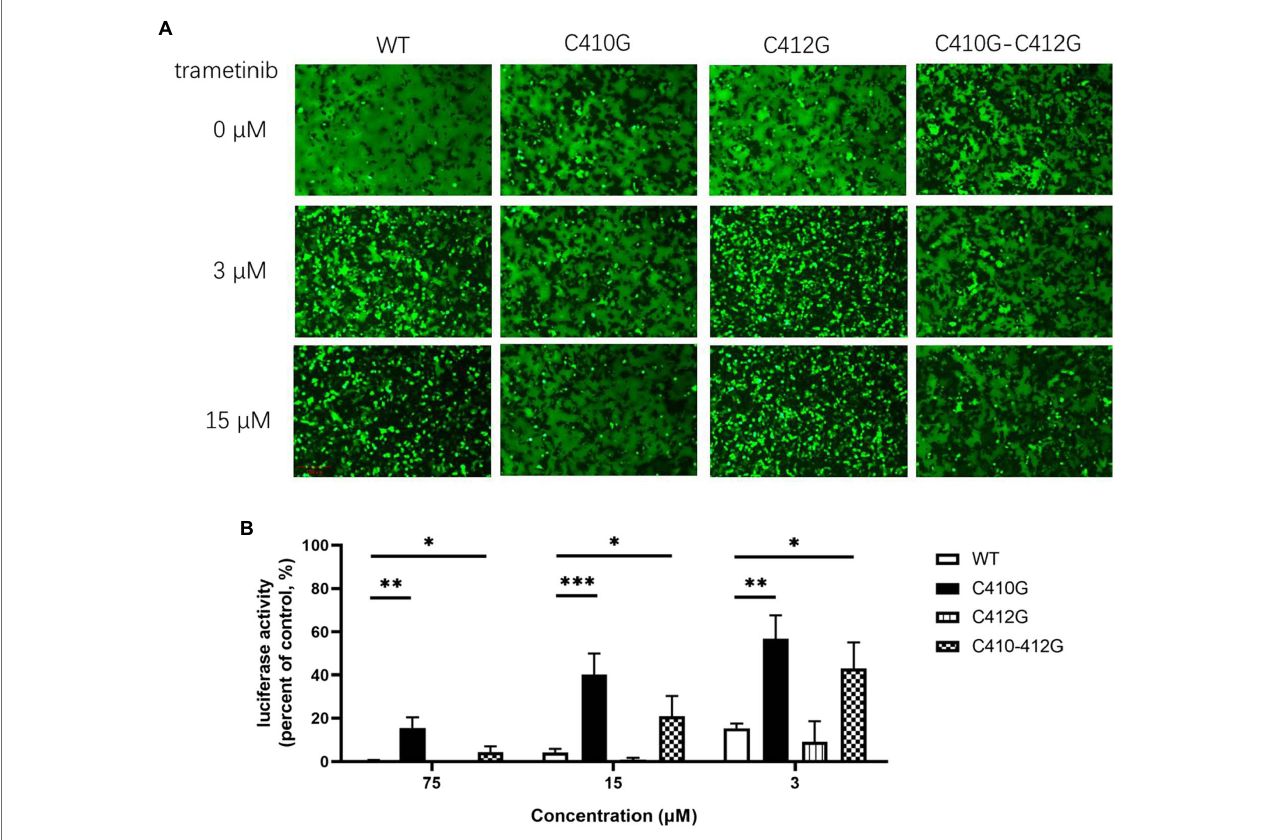
FIGURE 4 | Only C410G, but not C412G, conferred resistance to trametinib. (A) Both C410G and C410G/C412G mutants conferred resistance to the inhibition of trametinib, against LUJV GPC-mediated membrane fusion. Images are representative fields from three independent experiments. (B) Both C410G and C410G/C412G mutants conferred the resistance to trametinib, while both WT and C412G retained their sensitivity. Data are means ± SD from 3 to 4 independent experiments. *** p < 0.001; ** p < 0.01; and * p <